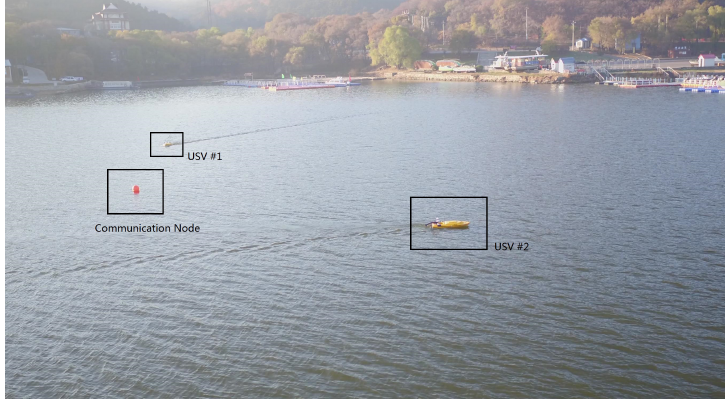
Figure 10. The lake experiment carried out with two USVs and one communication node. USV #1 is approaching the communication node to update its pheromone map, while #2 that has just visited the node is exploring the lake.